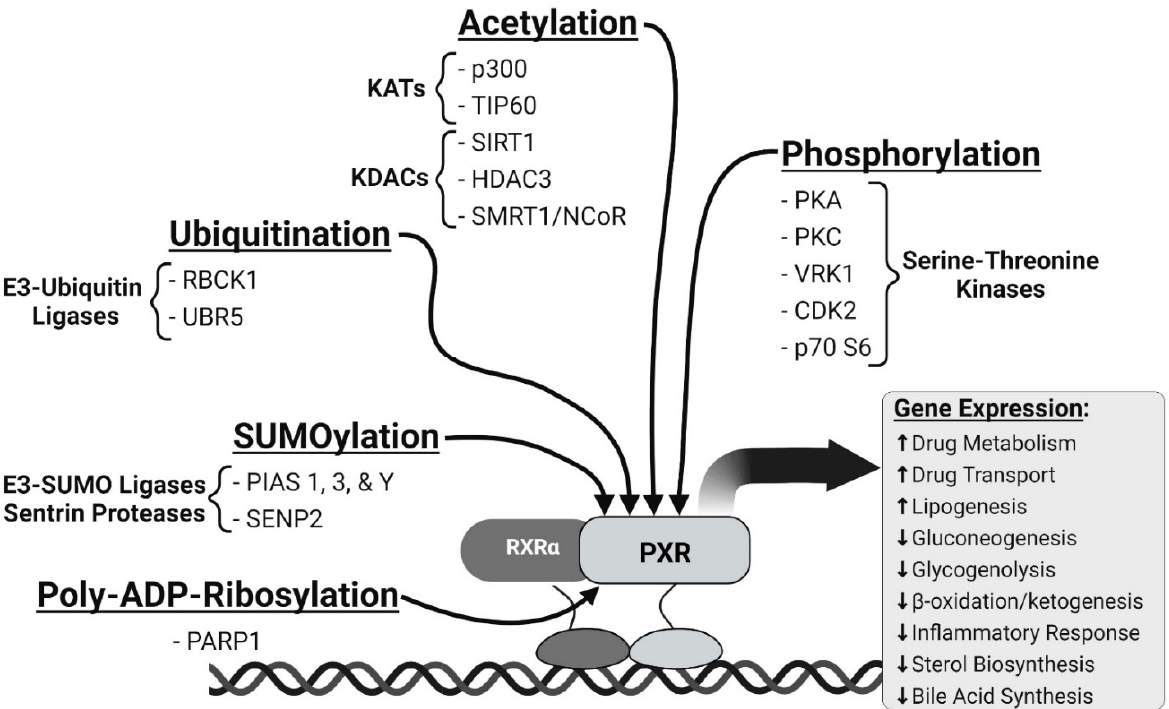
Figure 1. A pictorial diagram of the types of post-translational modification of pregnane X receptor (PXR, NR1I2). Created with BioRender.com (10 November 2021).